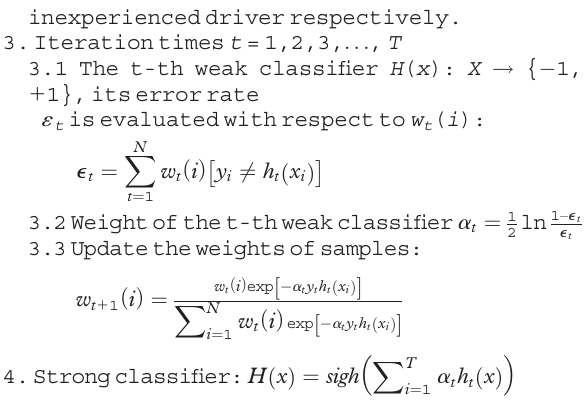
Figure 7 Driving features distribution at 1-th